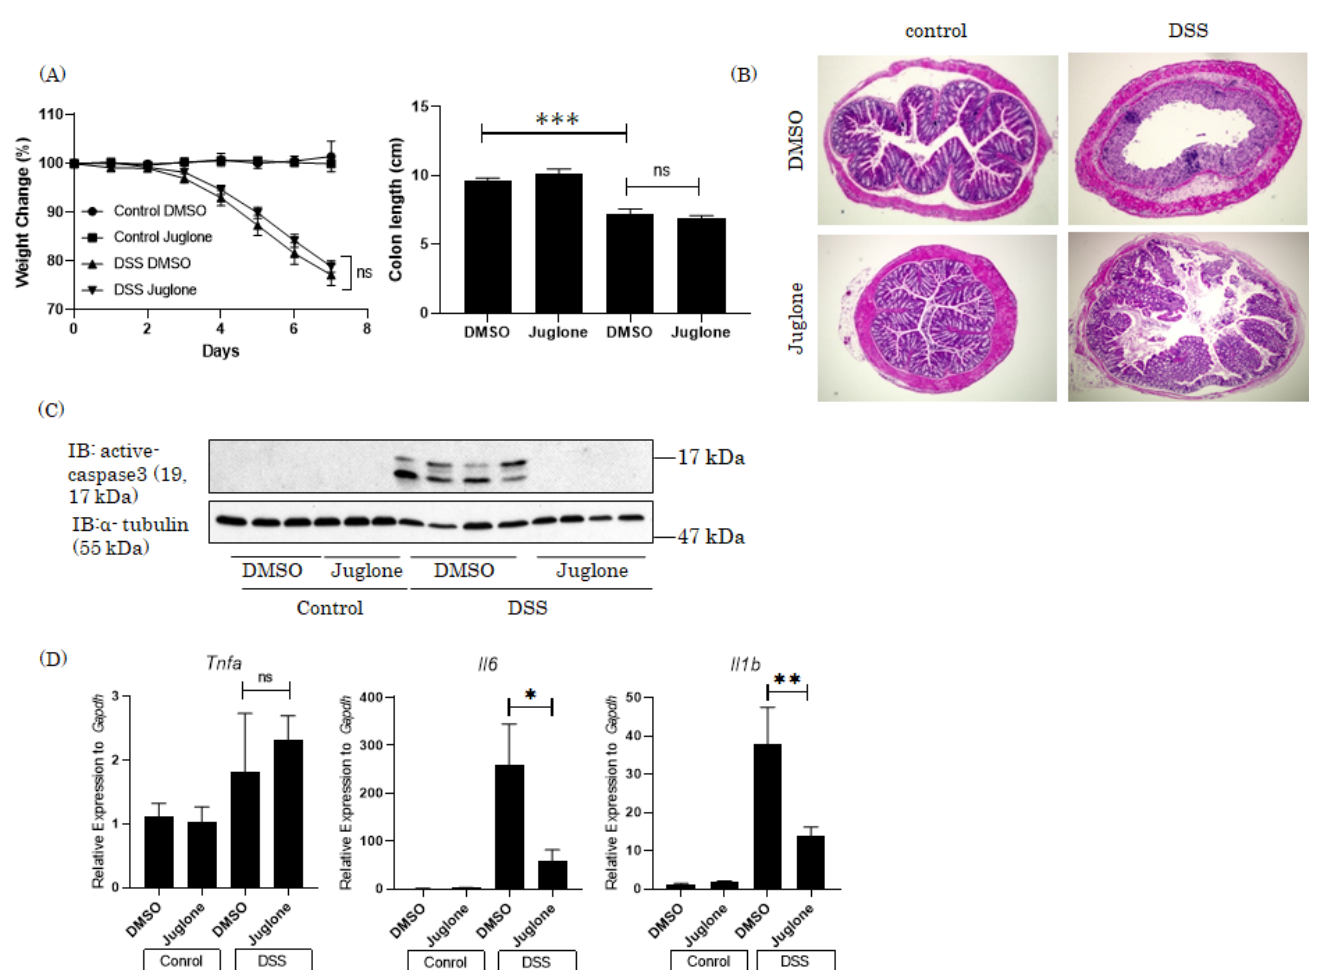
Figure 4. Pin1 inhibitors blocked the development of DSS-induced colitis. Juglone or solvent DMSO alone was administered orally once a day to the mice given drinking water with or without 3% DSS for 7 days (n = 6–10). ( A ) Body weight change of each mouse ( B ) Histology based on H&E staining of the colonic sections. ( C ) Active forms of caspase 3 and α -tubulin in the colons were detected by immunoblotting. ( D ) The mRNA expression levels of TNF α , Il6 and Il1b in the colons were measured by RT-PCR. Significant differences were identified by applying a one-way ANOVA followed by Tukey’s multiple comparisons test. n.s.: not significant, * p < 0.05, ** p < 0.01, *** p < 0.001 Values are means ± SEM.